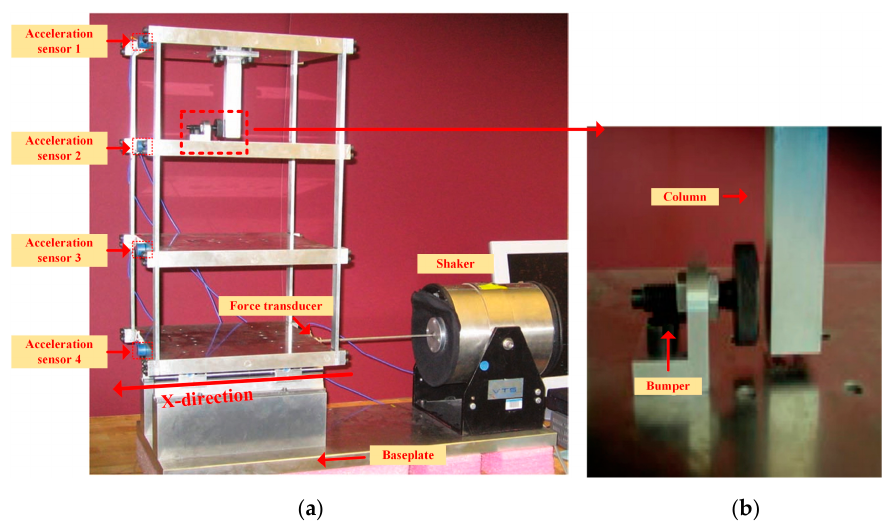
Figure 3. Test structure setup. ( a ) Three-story building structure; ( b ) An adjustable bumper. Table 1. Different state conditions of the structure.